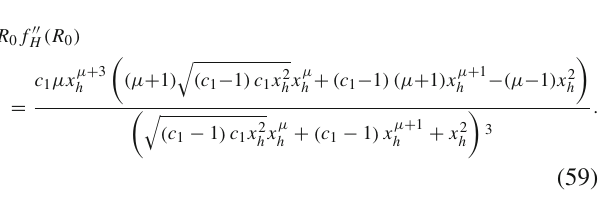
Fig. 12 Stability region of the Hu–Sawicki model. Figure on the left side shows the stability region allowed by Eq. (49) and figure on the right side shows the stability region allowed by Eq. (50)